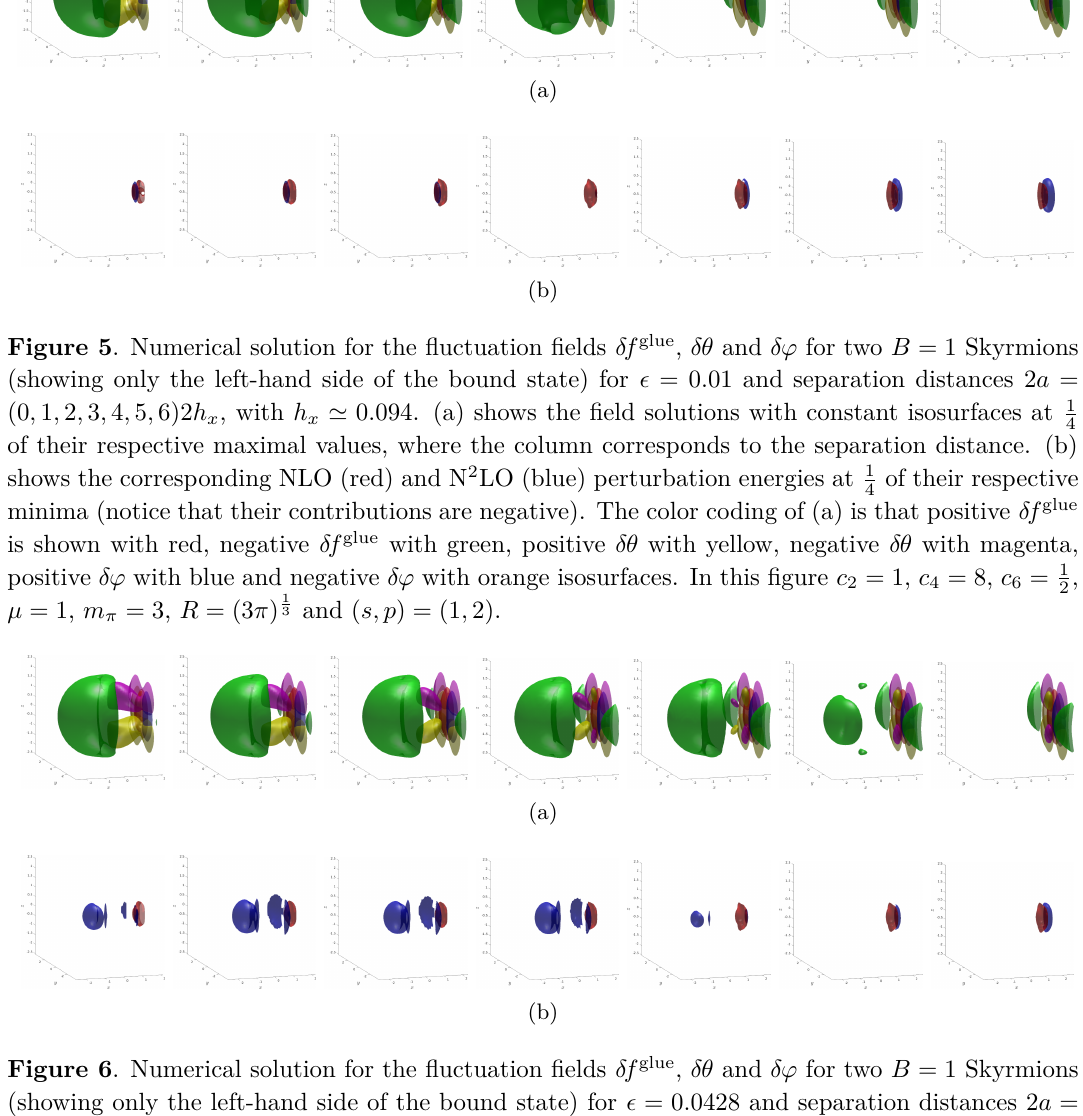
Figure 6 . Numerical solution for the fluctuation fields δf glue , δθ and δϕ for two B = 1 Skyrmions (showing only the left-hand side of the bound state) for (cid:15) = 0 . 0428 and separation distances 2 a = (0 , 1 , 2 , 3 , 4 , 5 , 6)2 h x , with h x ’ 0 . 094 . For further details, see the caption of figure